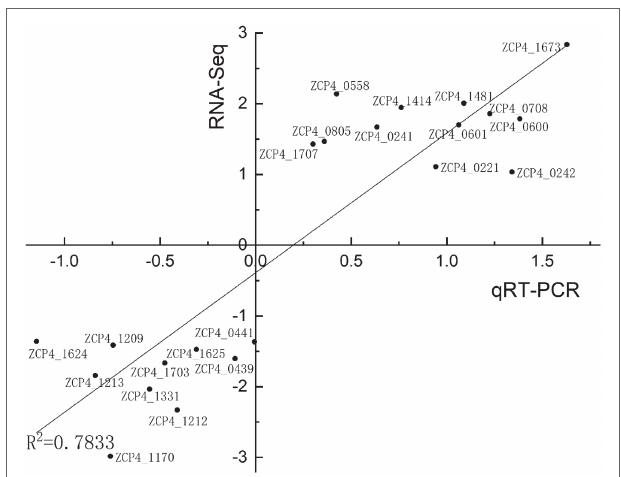
FIGURE 3 | Correlation between RNA-seq and qRT-PCR results for RNA- seq data verification. The gene expression ratios of RNA-seq and qRT-PCR data for the genes in Table 2 were log transformed (base 2), and the RNA- seq log2 ratio values were plotted against the qRT-PCR log2